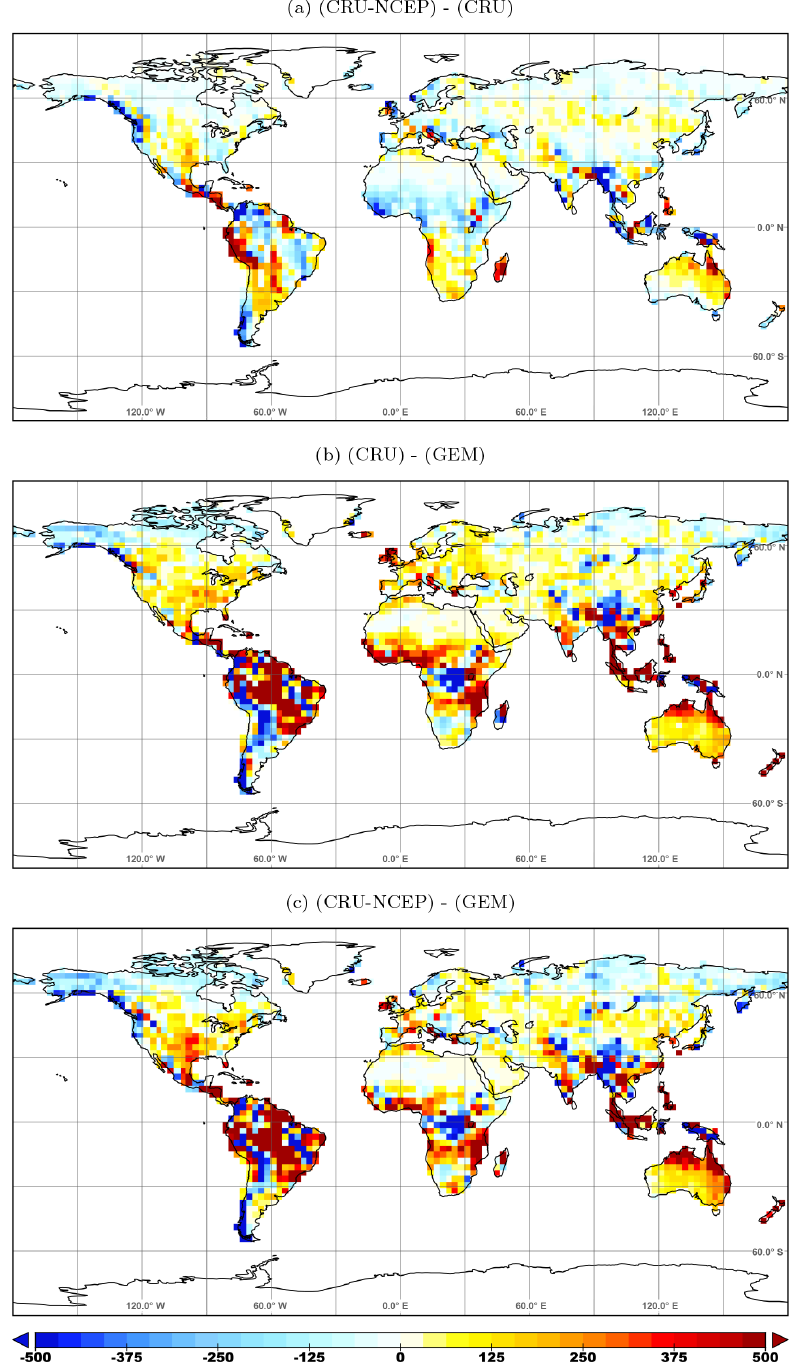
Figure 5. Comparison of spatial distribution patterns of annual total precipitation (mmyr − 1 ) (averaged over the period 2009–2010): (a) CRU- NCEP minus CRU, (b) CRU minus GEM, and (c) CRU-NCEP minus